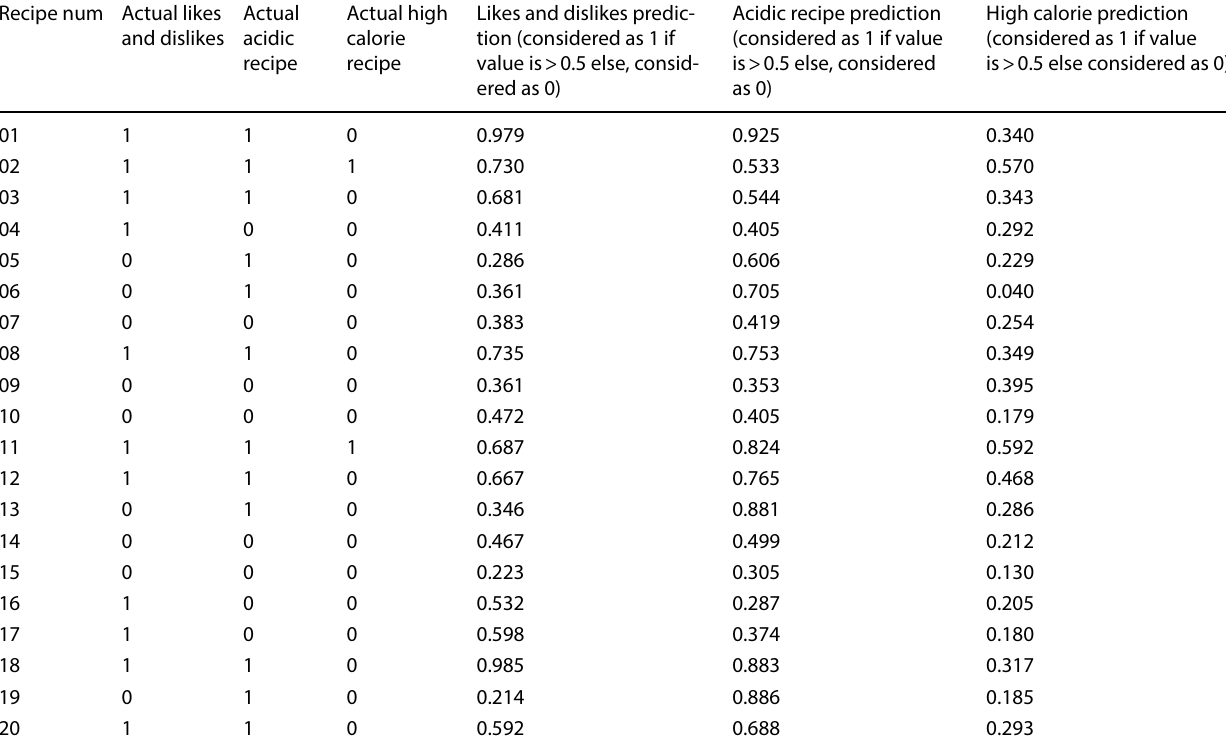
High calorie prediction (considered as 1 if